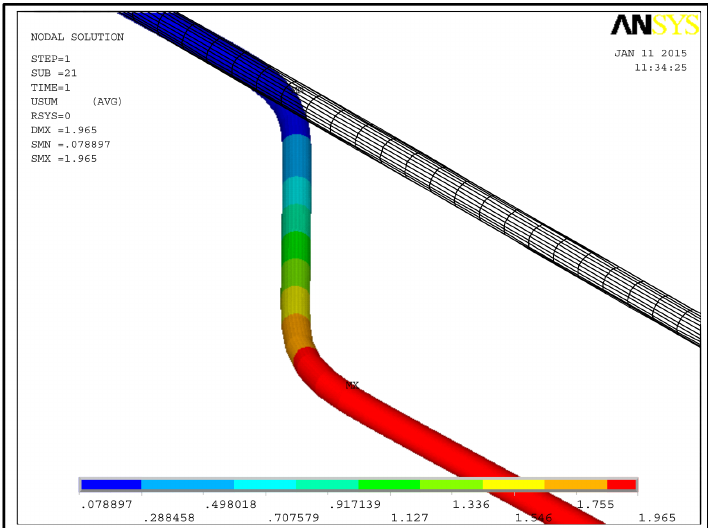
Figure 9. Pipeline displacement cloud diagram.